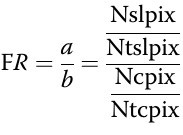
After calculation of the frequency ratio for each land- slide factor class using Microsoft Excel and GIS, the fre- quency ratio value for each factor class assigned through